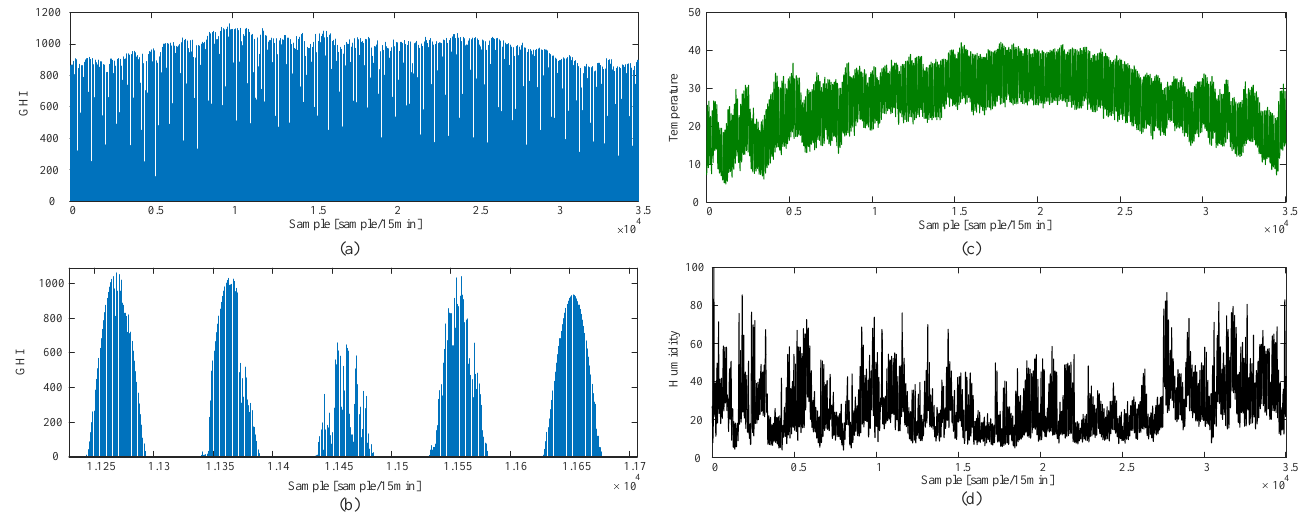
Figure 11. The data used in training and testing. ( a ) The GHI for a whole year. ( b ) The GHI for five working days. ( c ) The temperature in degree celsius. ( d ) Relative humidity in percentage.